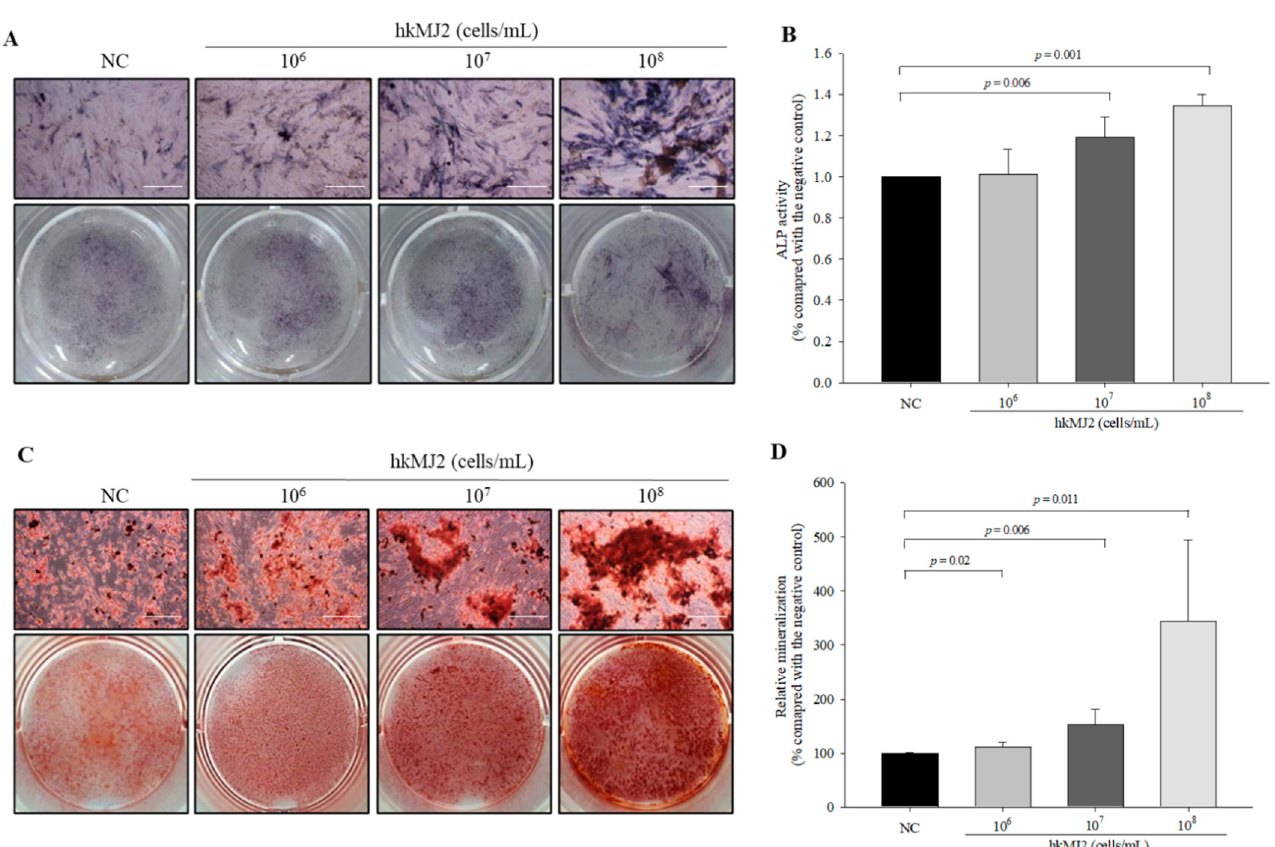
Figure 2. Effect of heat-killed P. freudenreichii MJ2 (hkMJ2) on ALP activity and osteoblast mineralization. ALP activity was analyzed by staining with p-nitrophenyl-phosphate ( × 100, scale bar = 100 µ m) ( A ) and quantified ( B ). Calcium deposits were stained by alizarin red S ( × 100, scale bar = 100 µ m) ( C ) and quantified ( D ). Values indicate the mean ± SD of three independent experiments performed in triplicate.